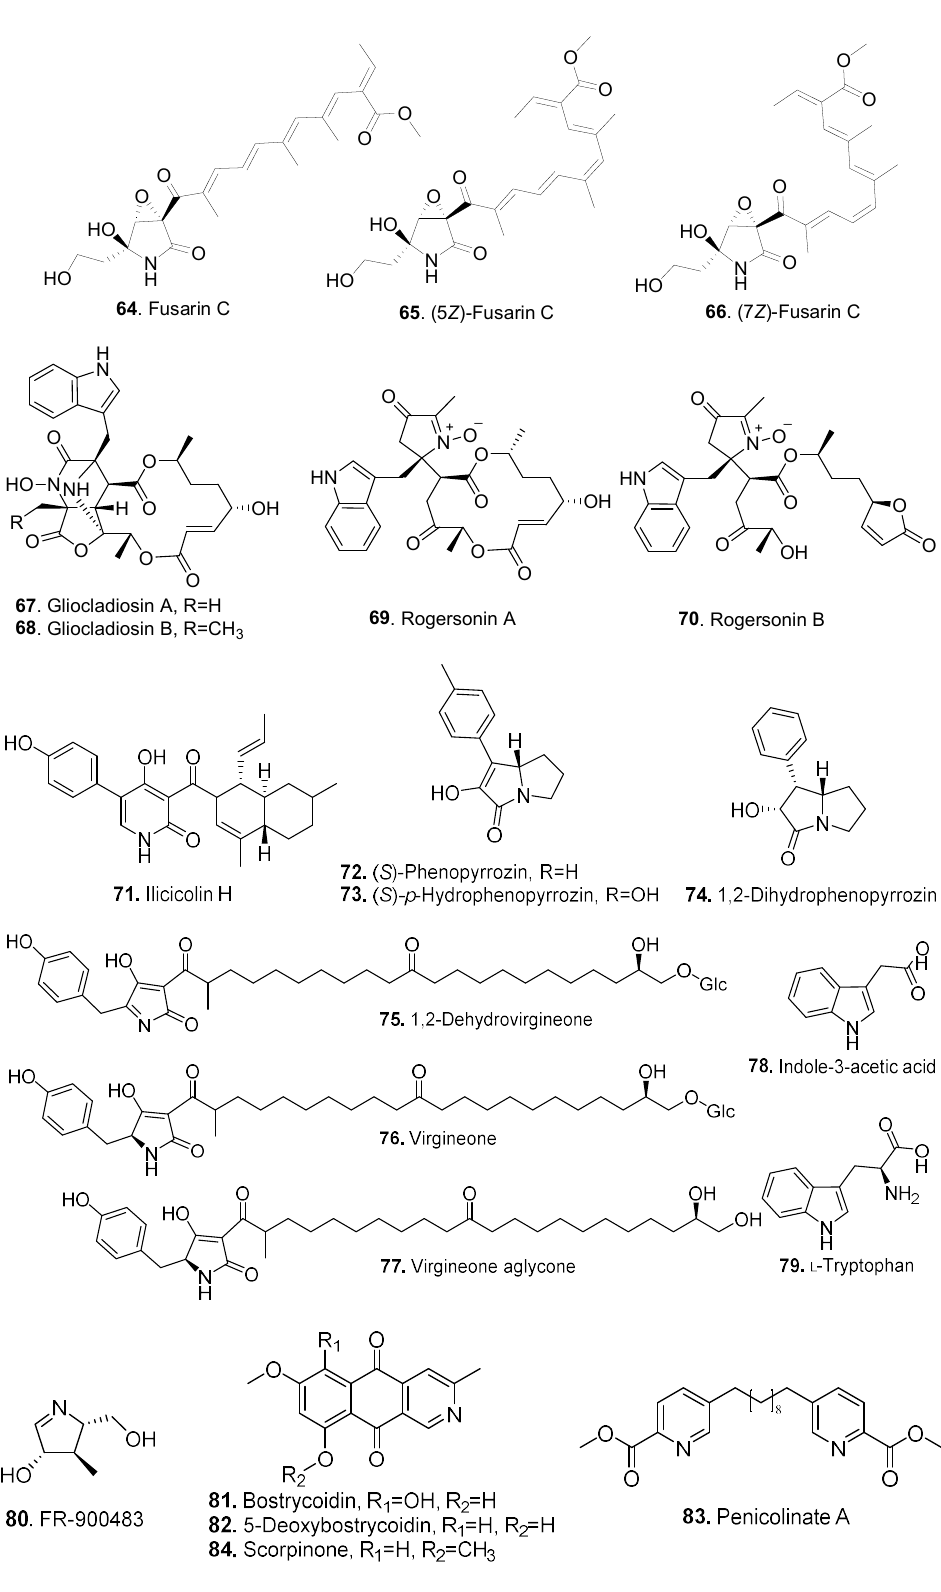
Figure 4. Other nitrogen-containing metabolites isolated from Clonostachys fungi. Both N-benzyl-3-phenyllactamide ( 57 ) and N-benzyl-3-phenylpropanamide ( 58 ) were isolated from Clonostachys compactiuscula FKR-0021